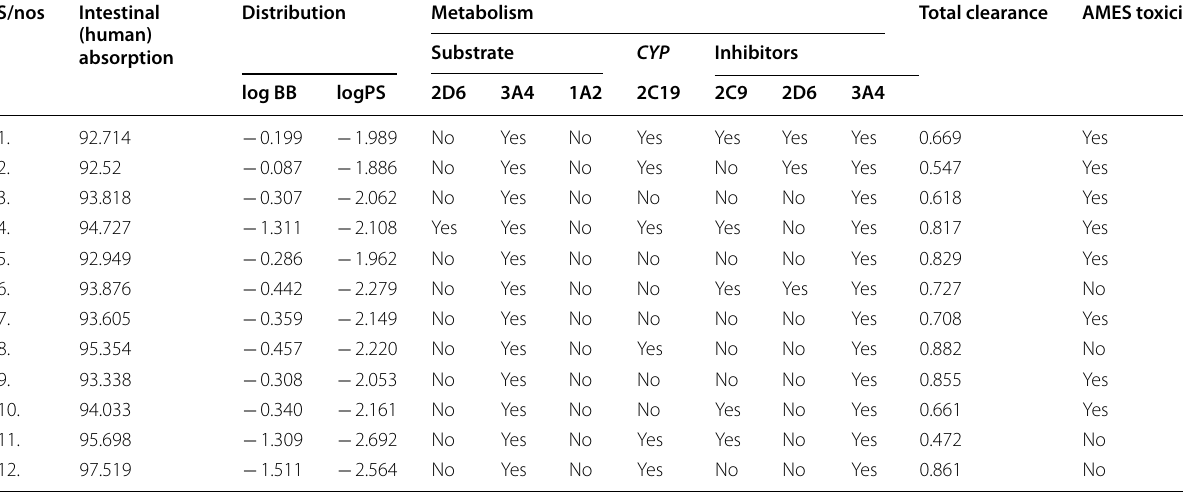
Table 8 Predicted ADMET properties of the designed chromen-2-ones S/nos Intestinal Distribution (human) absorption